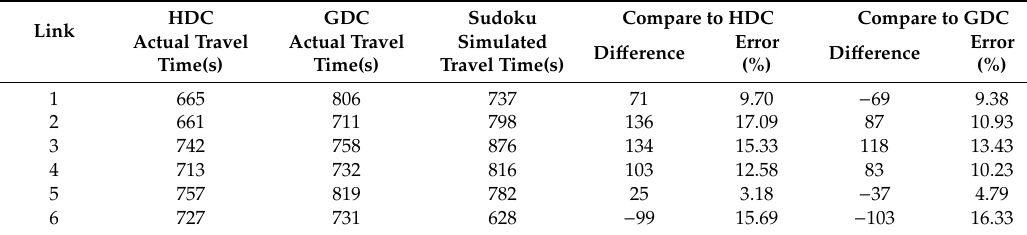
Table 2. Comparison of actual and simulated travel